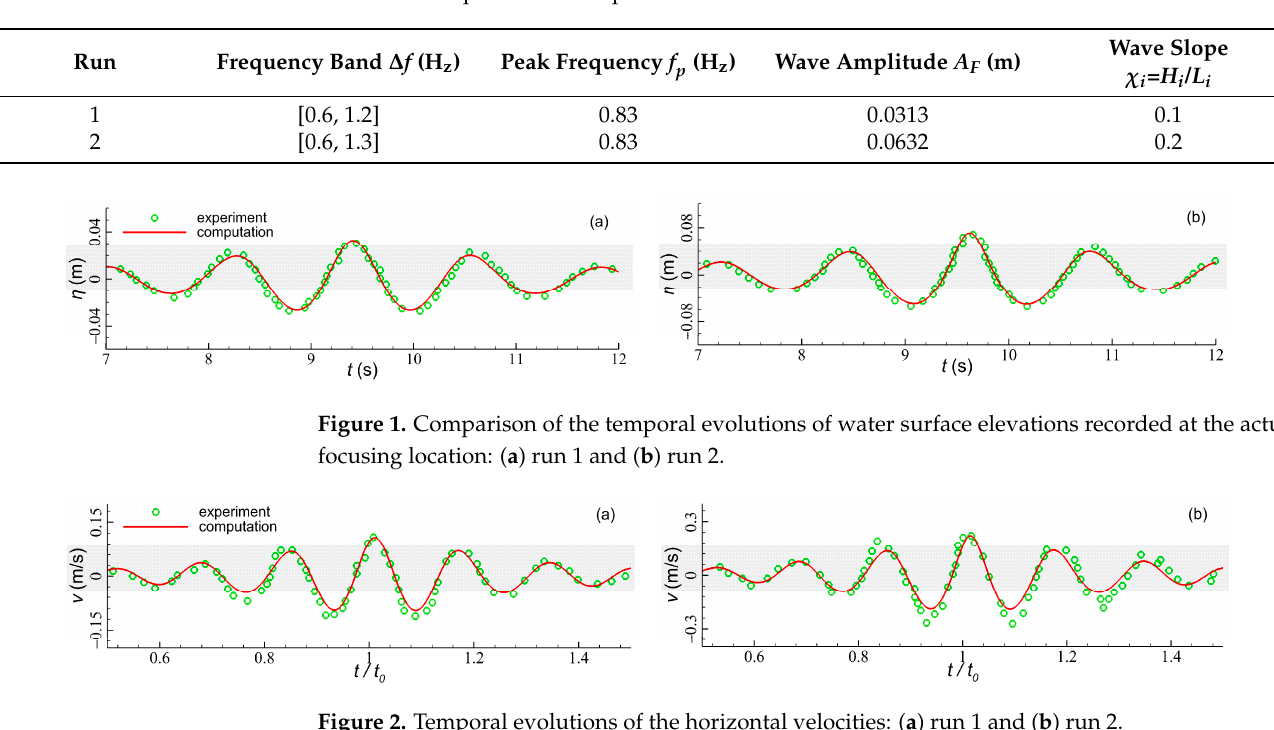
Table 1. Wave parameter setups.